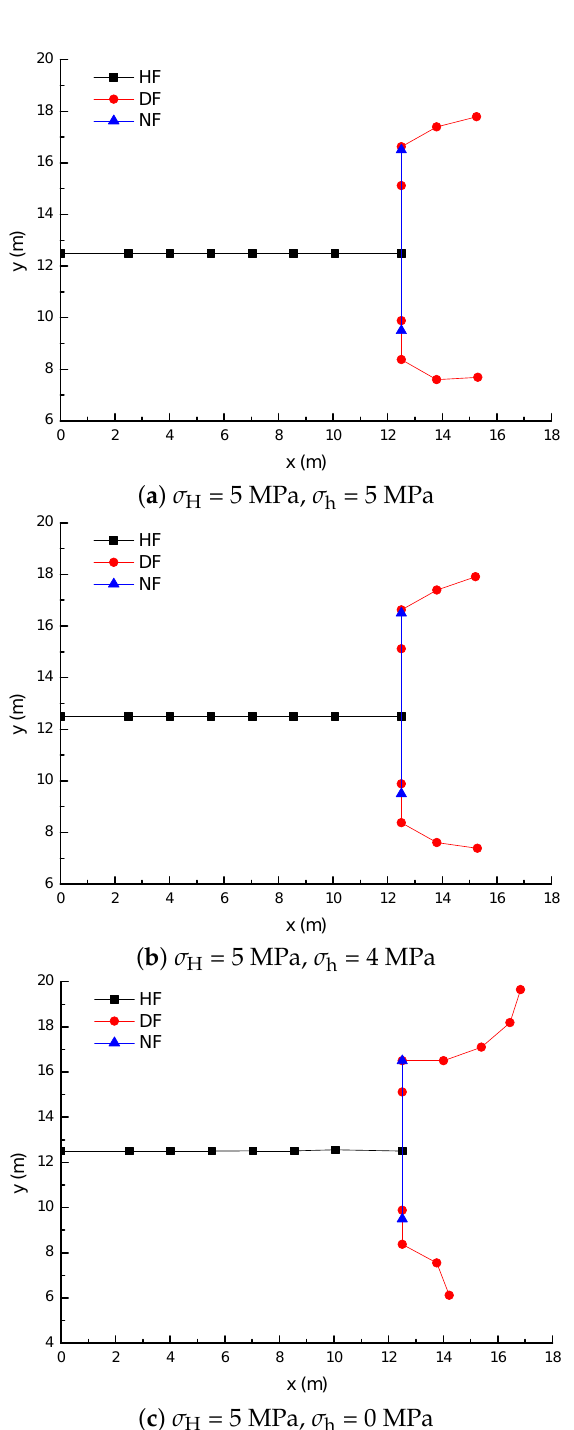
Figure 10. The crack propagation paths at different levels of remote horizontal principle stress difference. The flow rate in the DF is shown in Figure 14. It is obvious that the flow rate in the upper parts is much greater than that in the lower parts. Therefore, the fracture aperture and net pressure in the upper parts are greater than those in the lower parts for the same fluid viscosity. This might explain the results of fracture aperture and net pressure in Figures 12 and